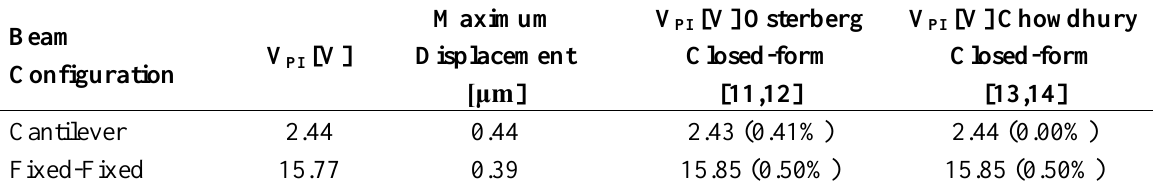
Table 3. Minimum constant gap case results (small